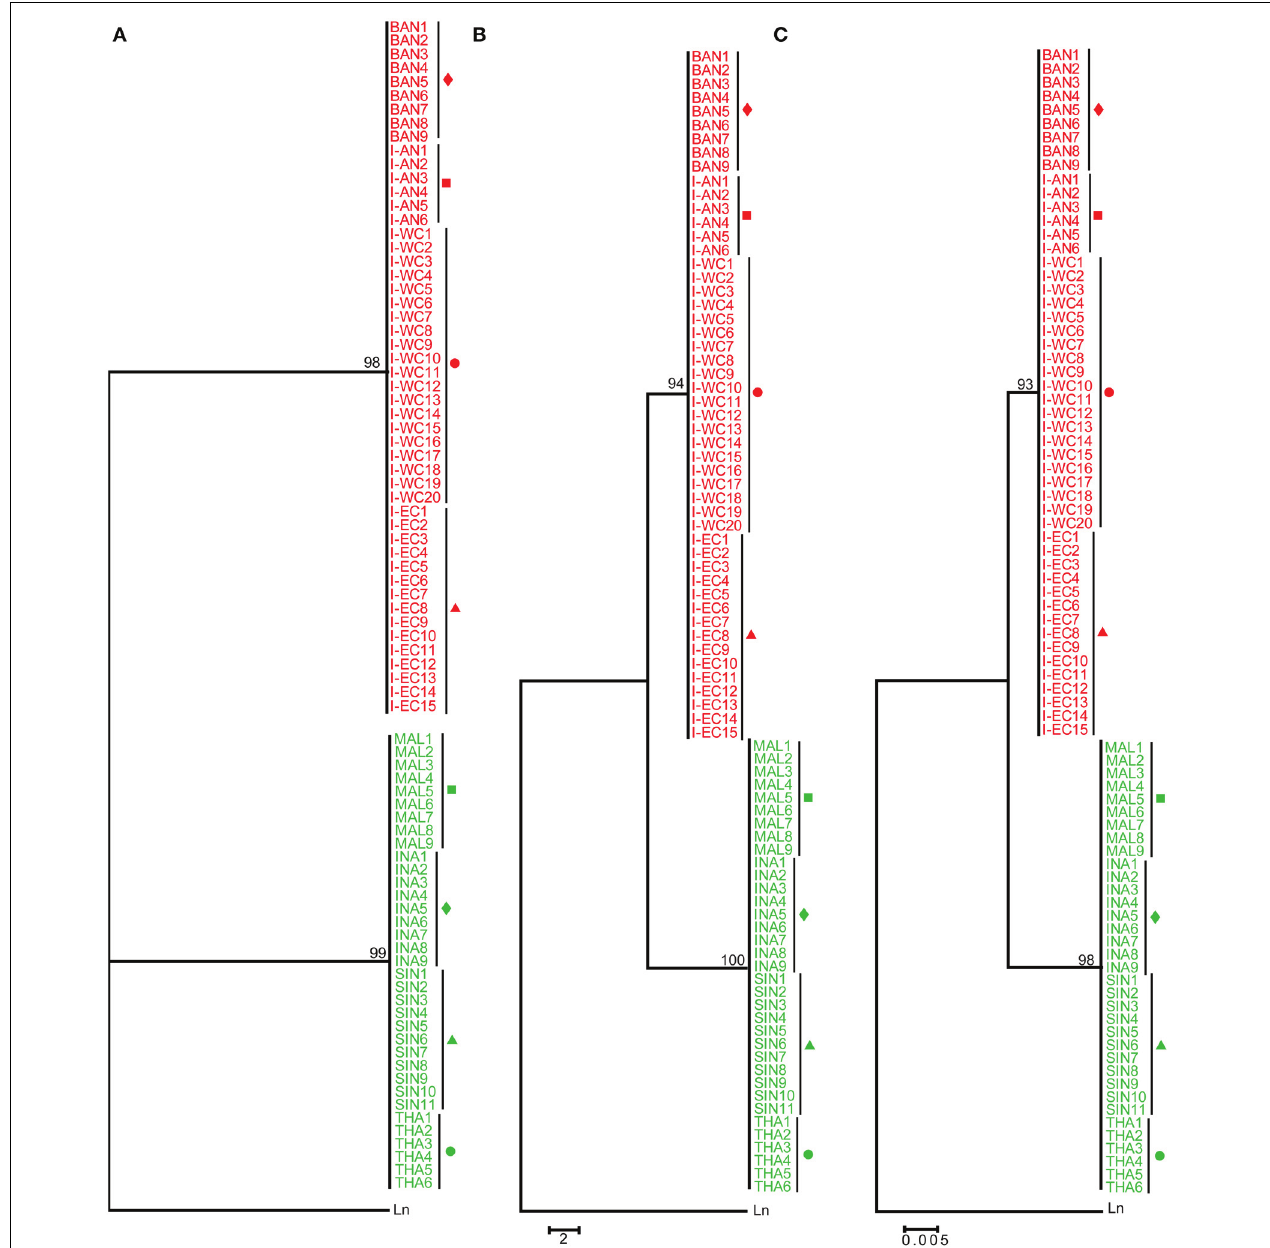
FIGURE 4 | Phylogenetic analyses based on 16S sequences. 16S rDNA sequences from eight regions (for labels and conditions see the legend of Figure 3 ) were used for ML (A) , MP (B) , and ME (C) analyses. Lates niloticus 16S rDNA sequence was used as an outgroup to root the tree.